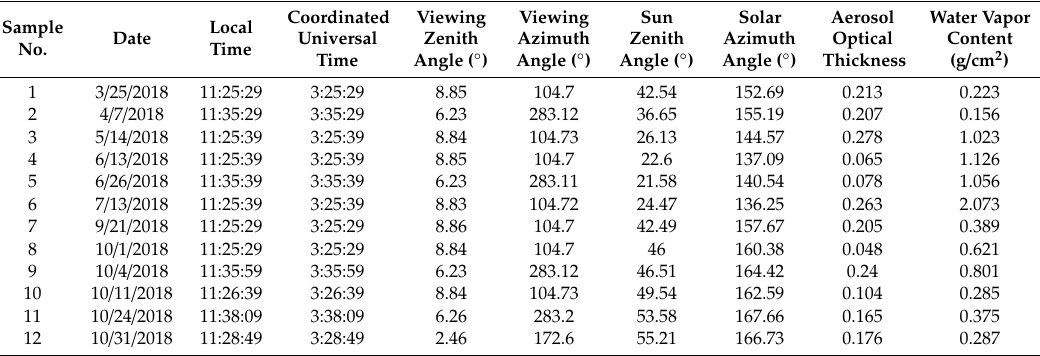
Table 1. Data acquisition information of Sentinel-2B / MSI over the Baotou site.